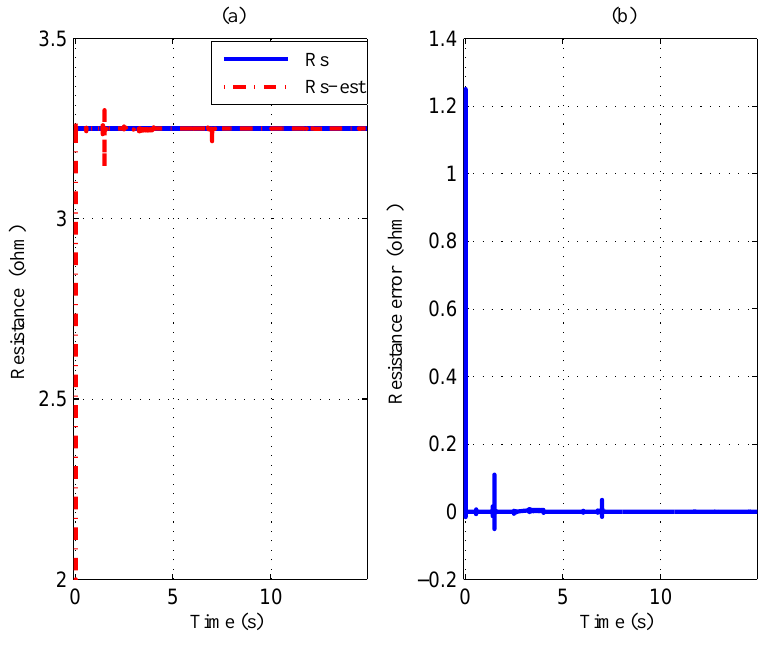
Figure 5. Estimation performance (nominal case): ( a ) estimated and real resistance; and ( b ) estimation error.